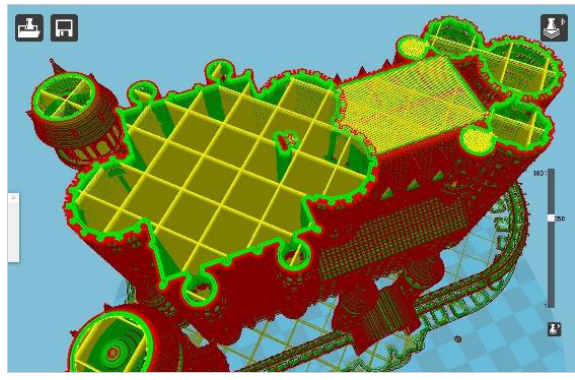
Figure 16. During 3D print of the medieval castle